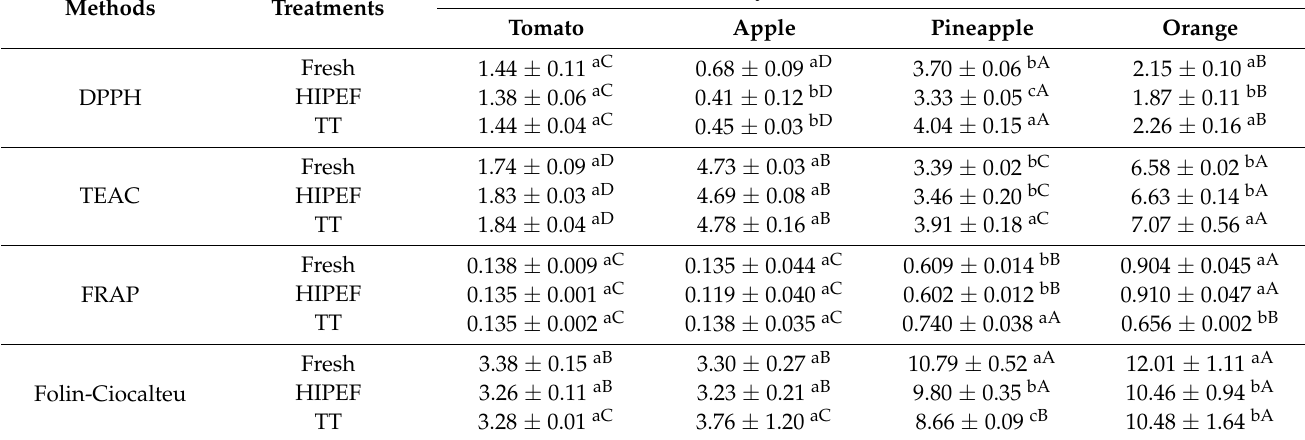
Table 3. Effect of high intensity pulsed electric field (HIPEF) and thermal treatment (TT) on in vitro antioxidant activity of